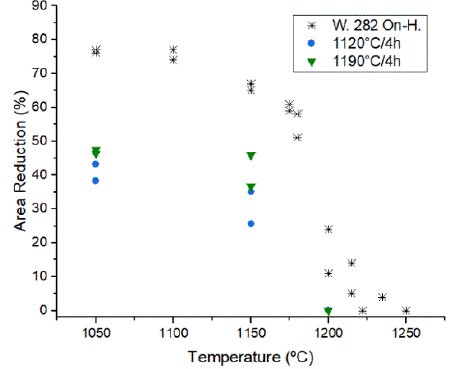
Figure 9. Gleeble on-heating ductility for cast and wrought Haynes ® 282 ® , data from [19].